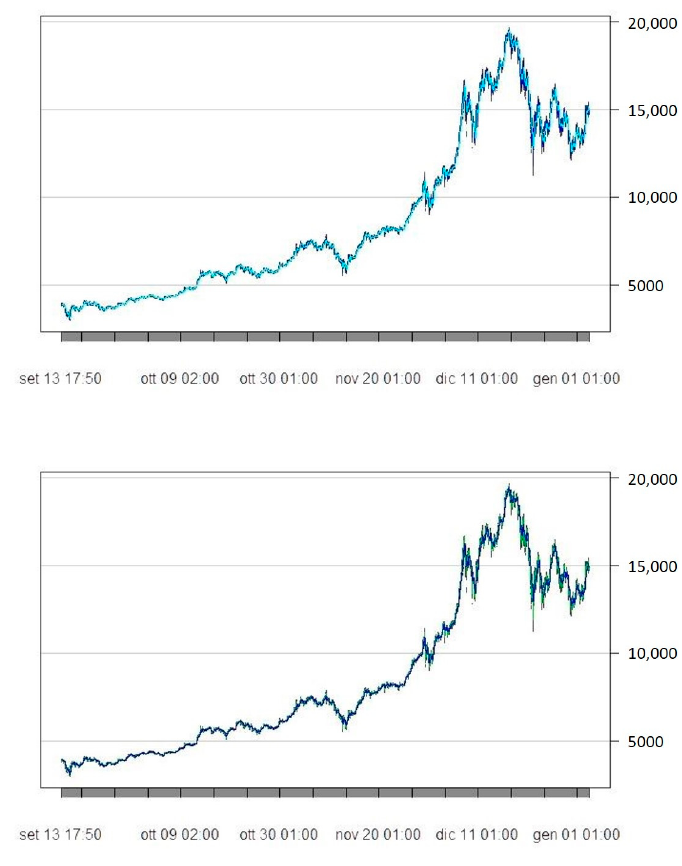
Figure 2. From top to bottom: SMA12 and SMA72 ( top panel), EMA12 and EMA72 ( bottom panel) superposed to the behavior of 5-min Bitcoin price series.